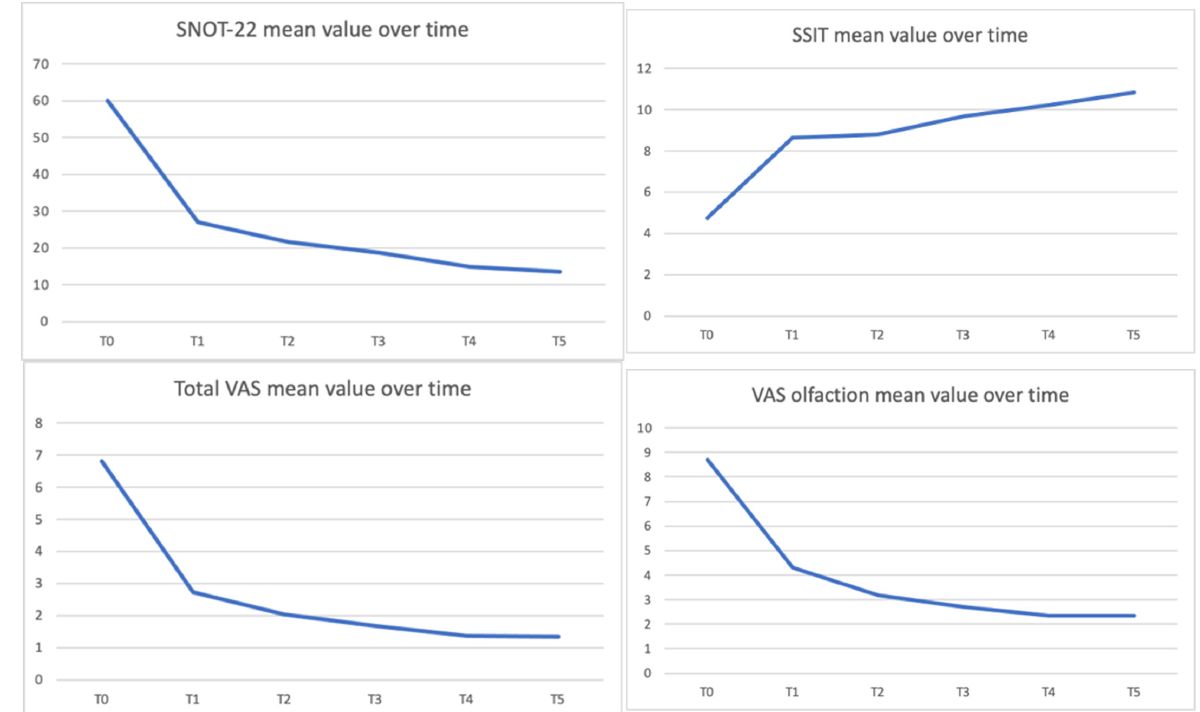
Figure 4. SNOT-22 (sinonasal outcome test),SSIT (sniffing sticks identification test), Total VAS (visual analogue scale) and VAS olfaction mean values over time.